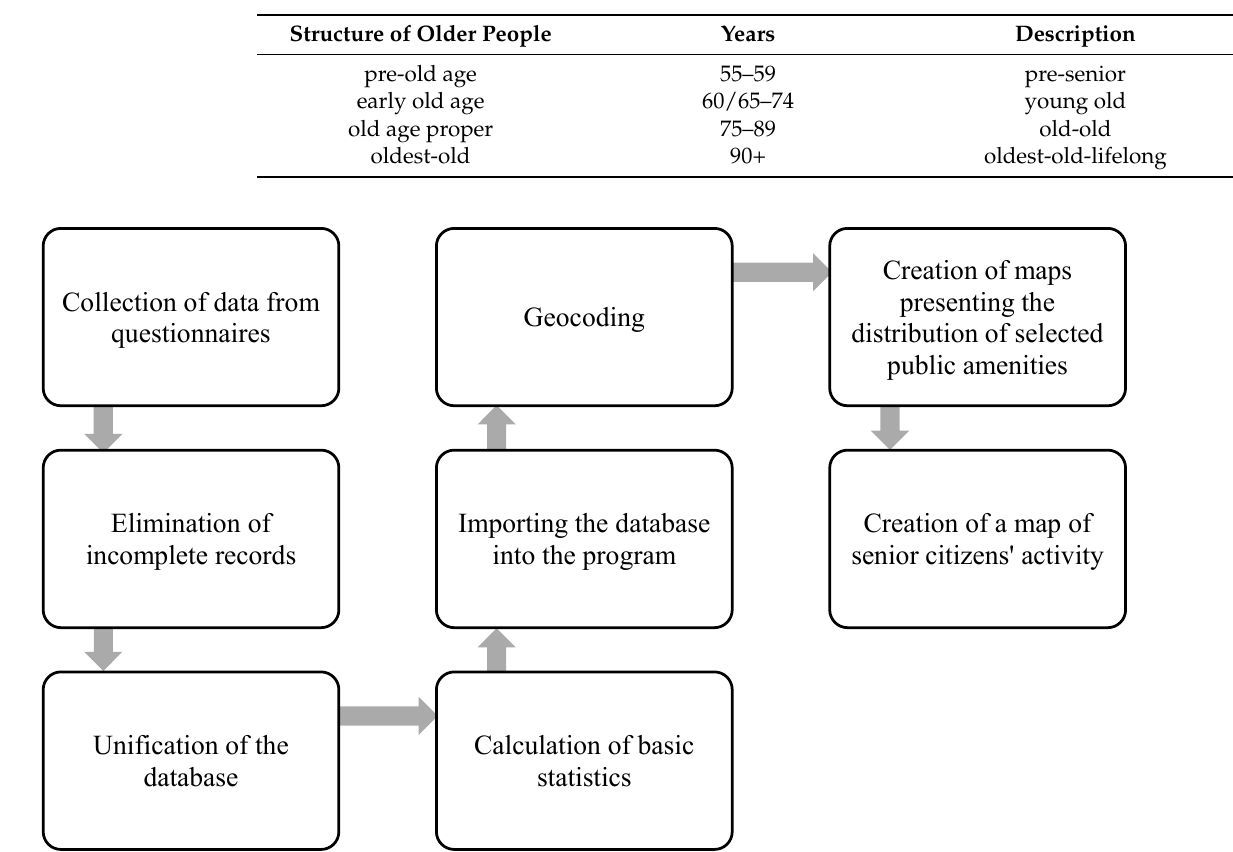
Table 2. Age structure of older people. Source: own elaboration based on [5].